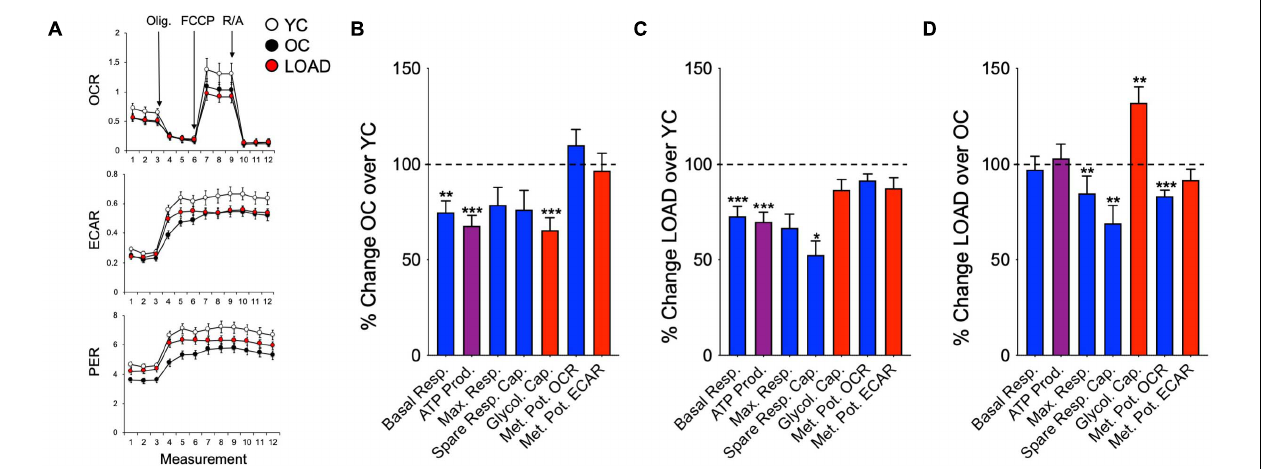
FIGURE 5 | Bioenergetic profiles of fibroblasts. (A) Profiles of Seahorse XFp Mito Stress Test in YC ( n = 16, average age 37.2 ± 10.7), OC ( n = 10, average age 65.3 ± 8.2), and LOAD ( n = 10, average age 71 ± 9.5) fibroblast lines. YC are marked in white, OC in black, and LOAD samples in red lines. (B–D) Calculated values of OCR (blue) and ECAR (red) parameters and results from Cell Energy Phenotype Test Report Generator plotted as percent change OC/YC (B) , LOAD/YC (C) , and LOAD/OC (D) . Data are means +/– SEM from 2 to 3 repeat experiments. * p < 0.1; ** p < 0.05; *** p < 0.01 using one-way ANOVA.